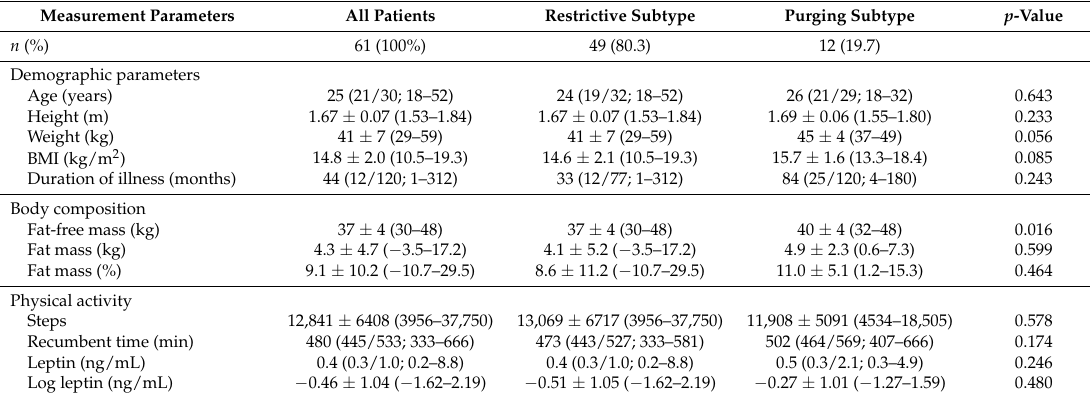
Table 1. Characterization of the study